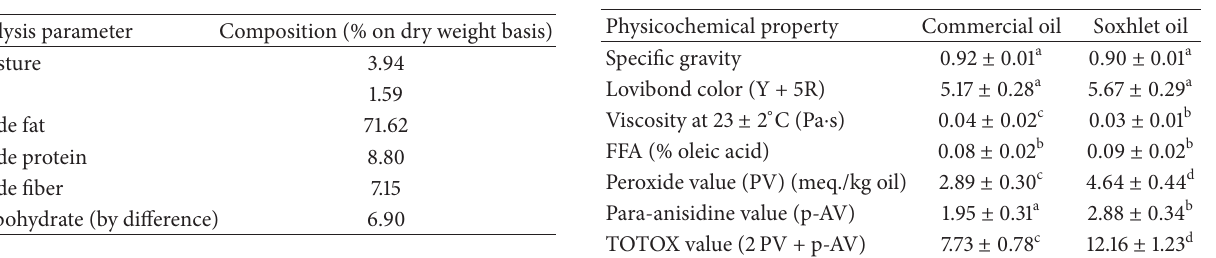
Table 2: Physicochemical properties of the Soxhlet extracted coconut oil e